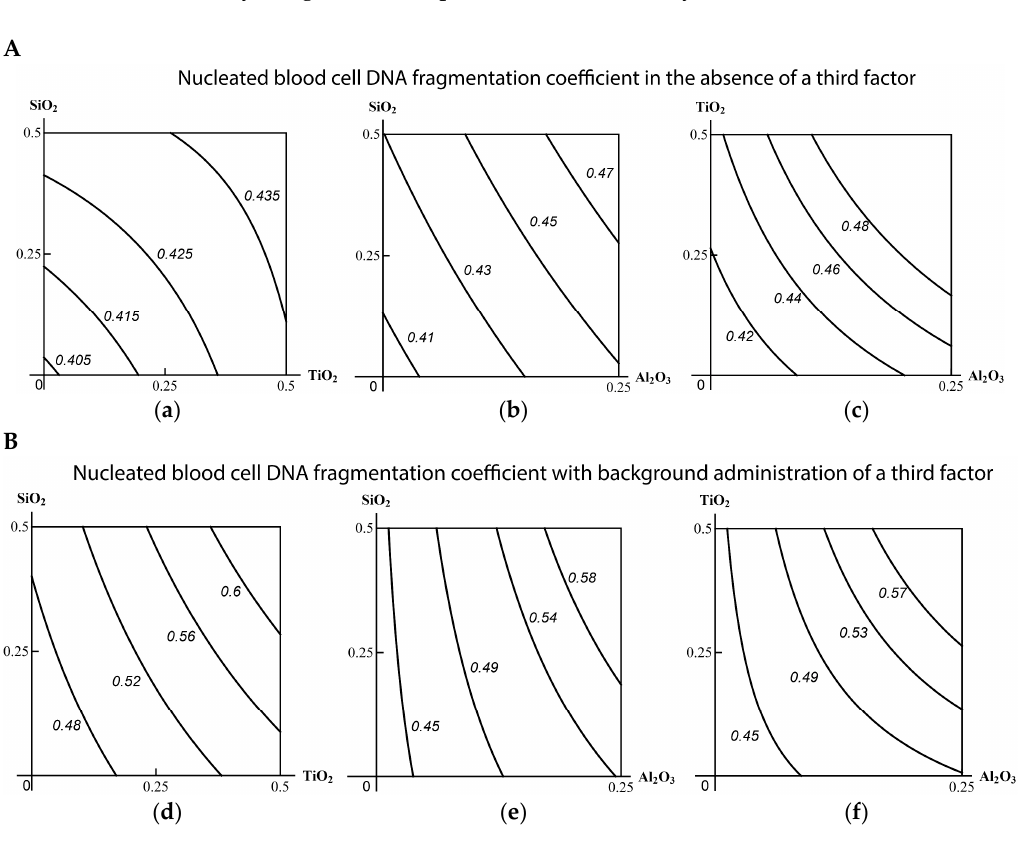
Figure 9. Isoboles of binary combined genotoxicity assessed by an increase in nucleated blood cell DNA fragmentation coefficient. ( А ) in the absence of a third factor under exposure to: ( а ) SiO 2 -NP + TiO 2 -NP (subadditivity); ( b ) SiO 2 -NP + Al 2 O 3 -NP (additivity); ( c ) TiO 2 -NP + Al 2 O 3 -NP (superadditivity). ( B ) with background administration of a third component: ( d ) Al 2 O 3 -NP to SiO 2 -NP + TiO 2 -NP (additivity); ( e ) TiO 2 -NP to SiO 2 -NP + Al 2 O 3 -NP (single-factor action with transformation into additivity); ( f ) SiO 2 -NP to Т iO 2 -NP + Al 2 O 3 -NP (superadditivity). The axes represent corresponding МеО -NPs in mg per rat; the numbers at the isobole denote the dimensionless quantity C fr .